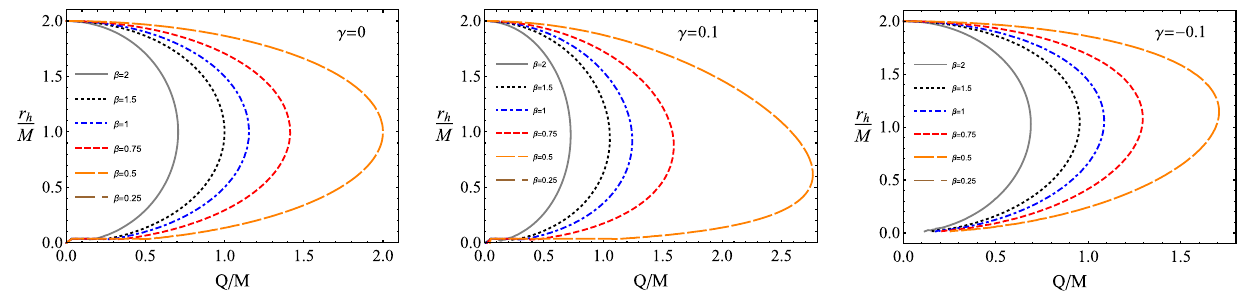
Fig. 1 Graphical behaviour of the event horizon radius is a function of the parameter γ for the different values of the parameter β